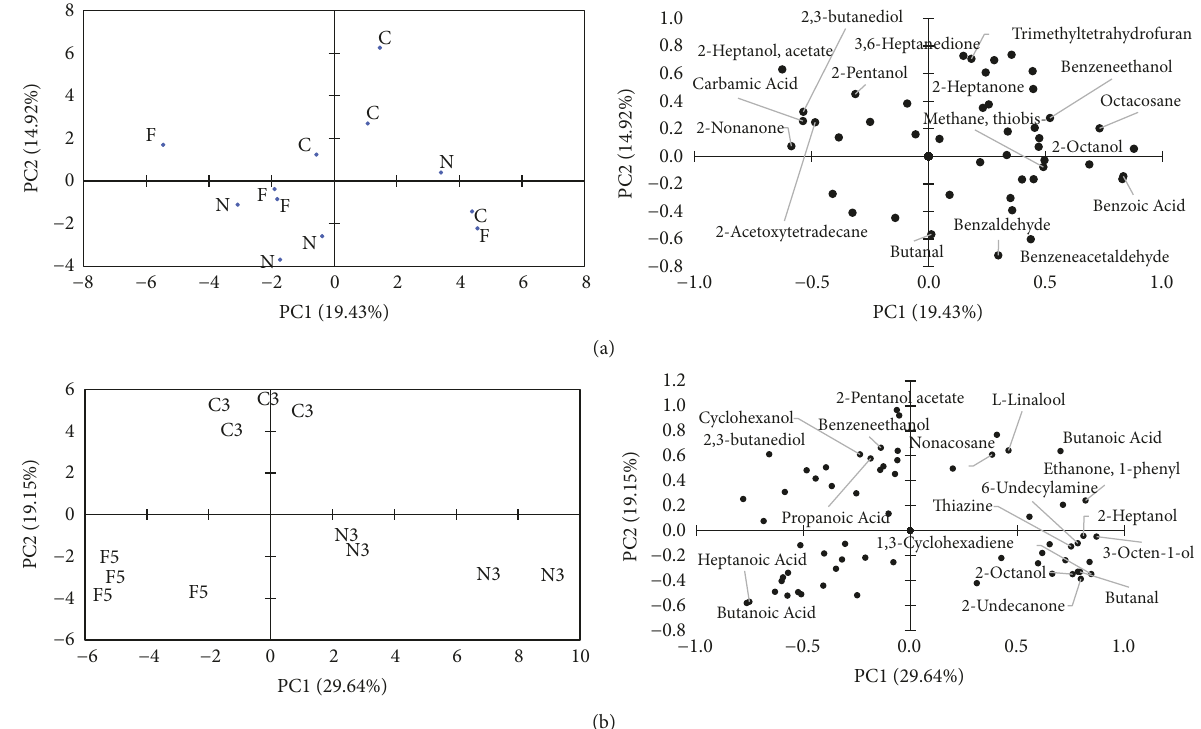
Figure 2: Principal components analysis score and loading plots of fresh (a) and fully fermented (b) beans. Sample codes are as in Table 1. Values in parenthesis represent the percentage of variance explained by each